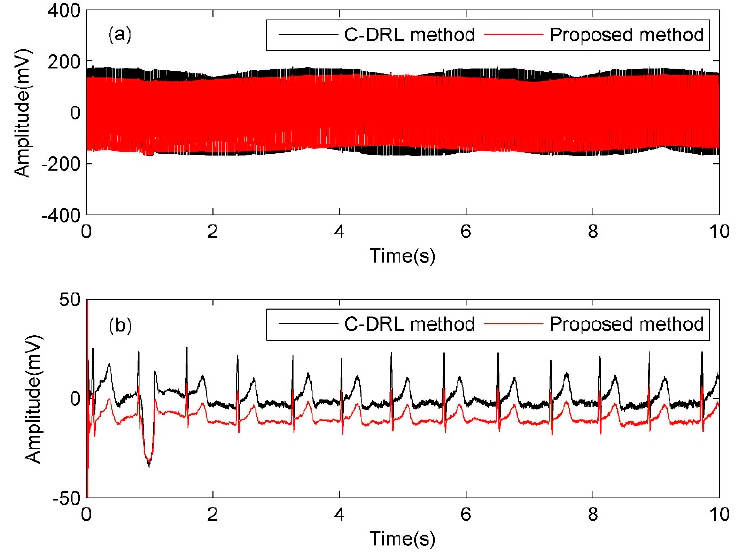
Figure 14. Simultaneous measurement results of human chest ECG acquisition with small amplitude swing of upper limb, ( a ) time-domain waveform of original signal, ( b ) ECG signal processed by software notch.